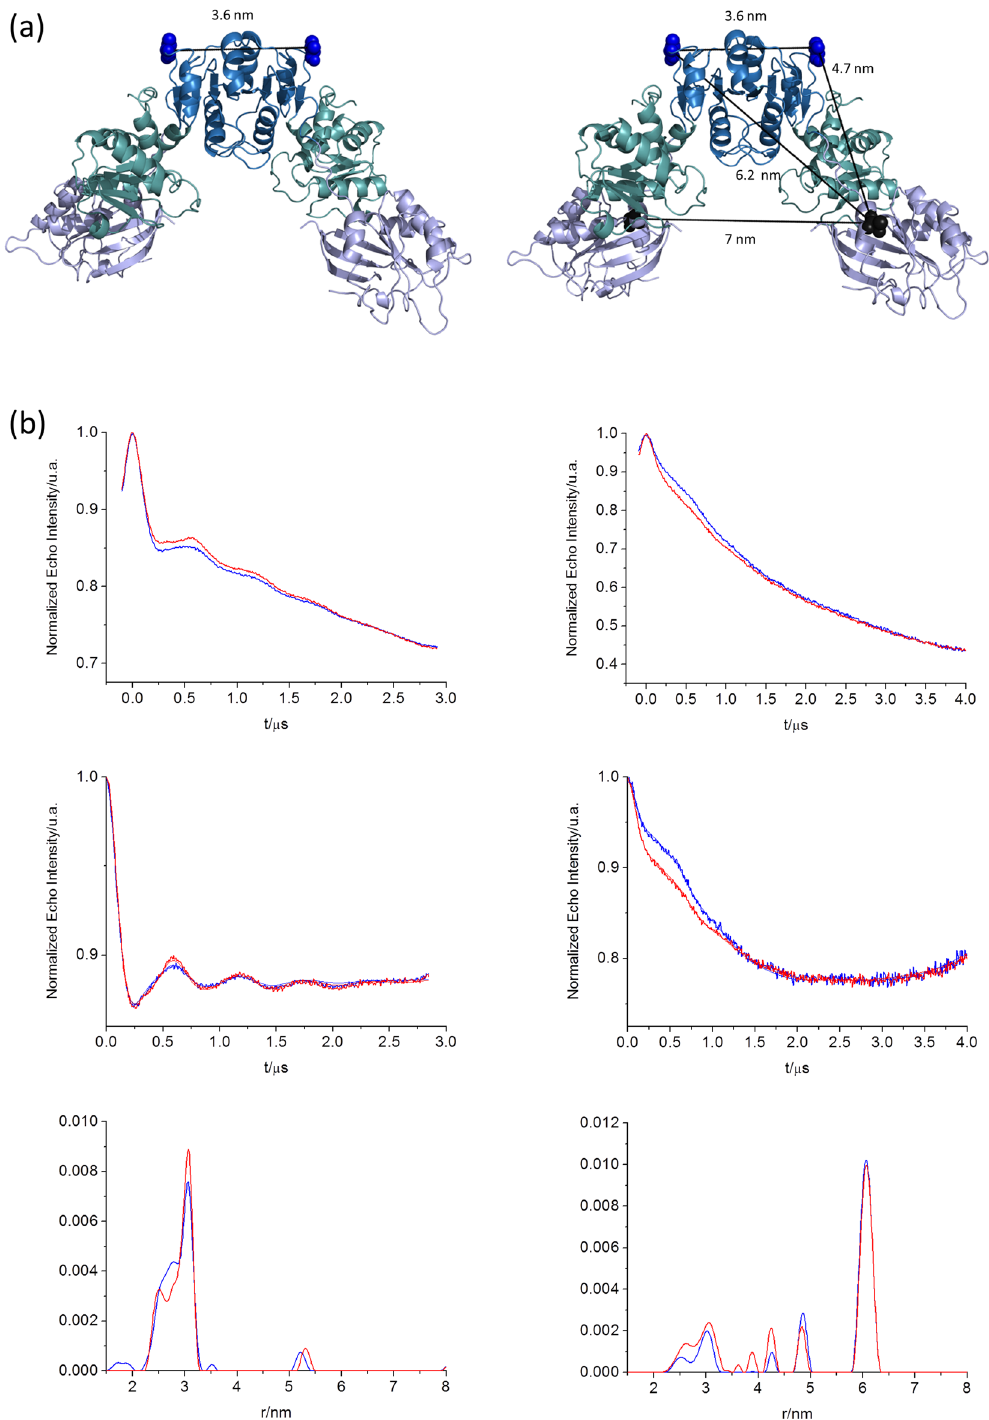
Figure 8. PELDOR of spin labeled V261C and V26C-T164C with HydF dimer structure representation. (Panel a) Cartoon representation of HydF dimer structure with the indication of the distance between the residues V261 (left) and between residues V261 (blue) and T164 (black) (right). (Panel b) PELDOR data of mutant V261C (left) and V26C-T164C (right), in the absence (blue) and in the presence (red) of GTP before (upper panels) and after (middle panels) background correction, Tikhonov-derived distance distributions in the absence (blue) and in the presence (red) of the nucleotide, are shown in the bottom